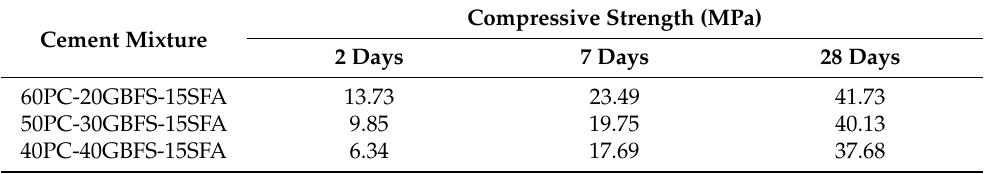
Table 3. Compressive strength of the cement mortar samples.